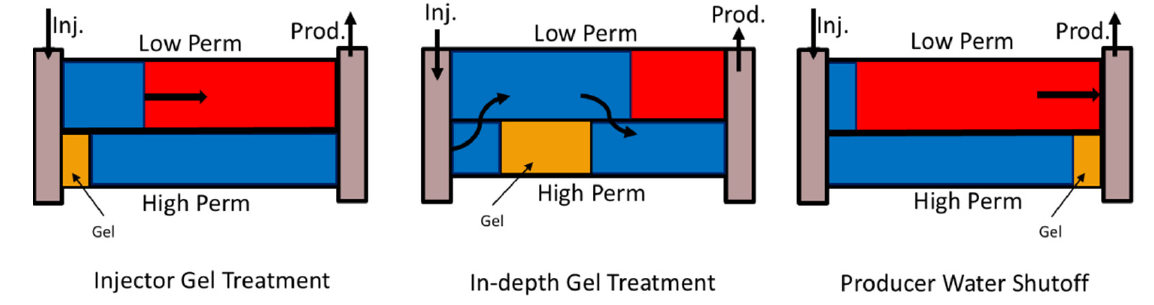
Figure 1. Application of gel treatment.